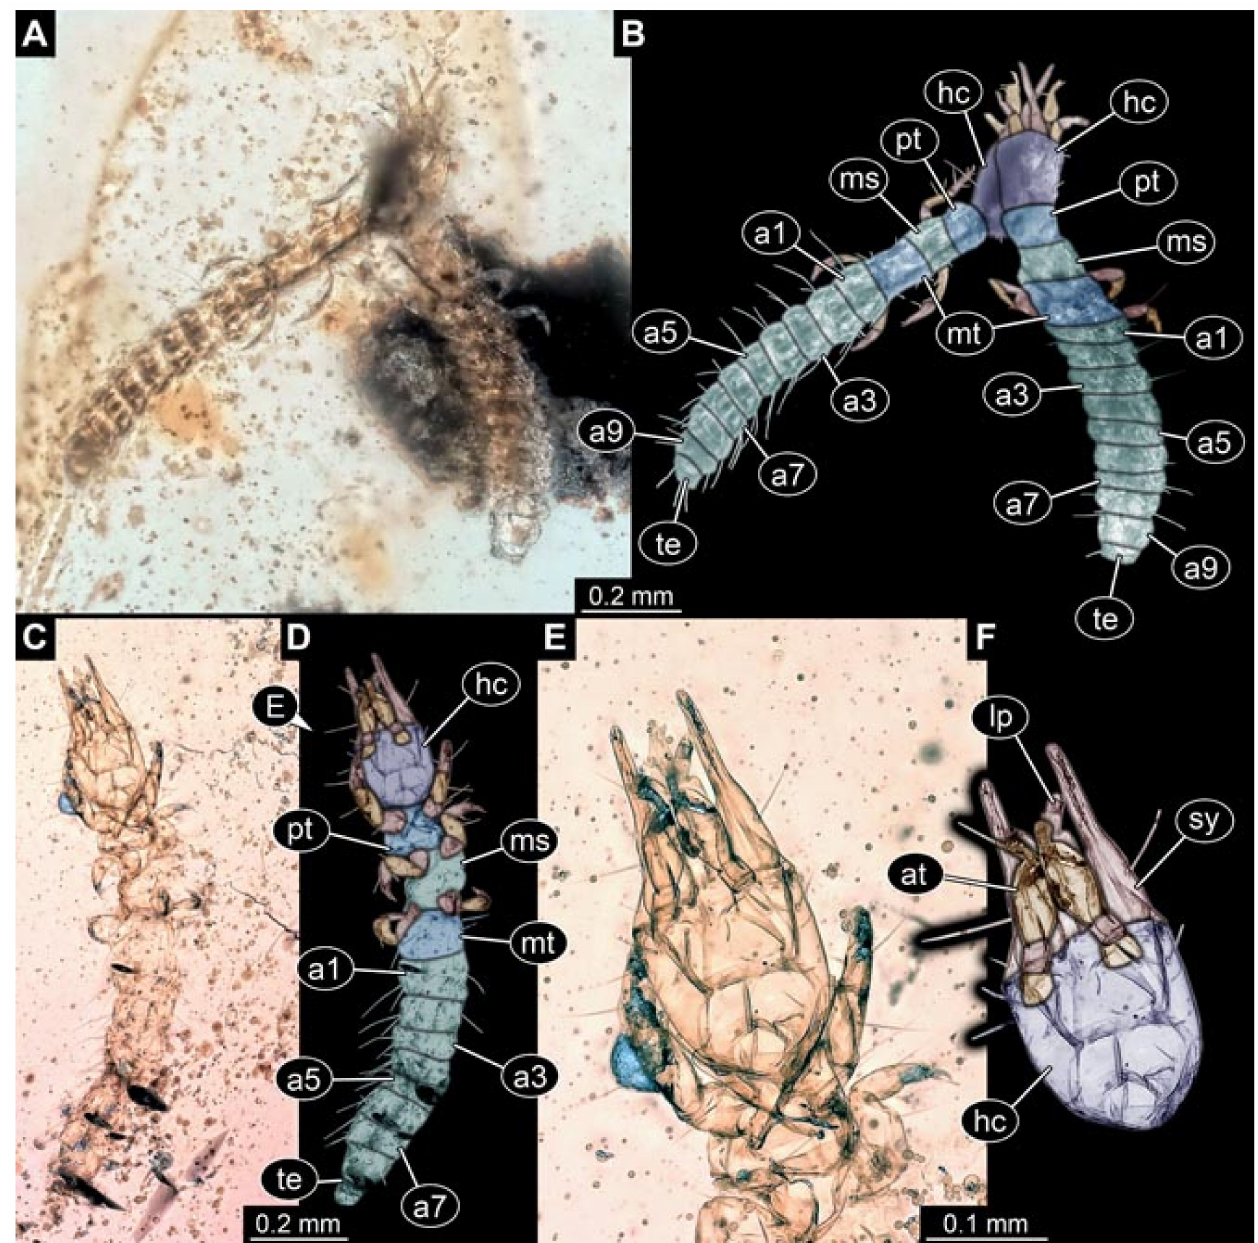
Figure 18. Specimens in Myanmar amber. ( A – B ) Specimen 5844 (PED 0900-5, left) and specimen 5845 (PED 0900-6, right). ( A ) Dorsal view. ( B ) Dorsal view, colour-marked. ( C – F ) Specimen 5846 (PED 0900-7). ( C ) Ventral view. ( D ) Ventral view, colour-marked. ( E ) Close-up of head in ventral view. ( F ) Close-up of head in ventral view, colour-marked. Abbreviations: a1–a9 = abdomen segment 1–9; at = antenna; hc = head capsule; lp = labial palp; ms = mesothorax; mt = metathorax; pt = prothorax; sy = stylet; te = trunk